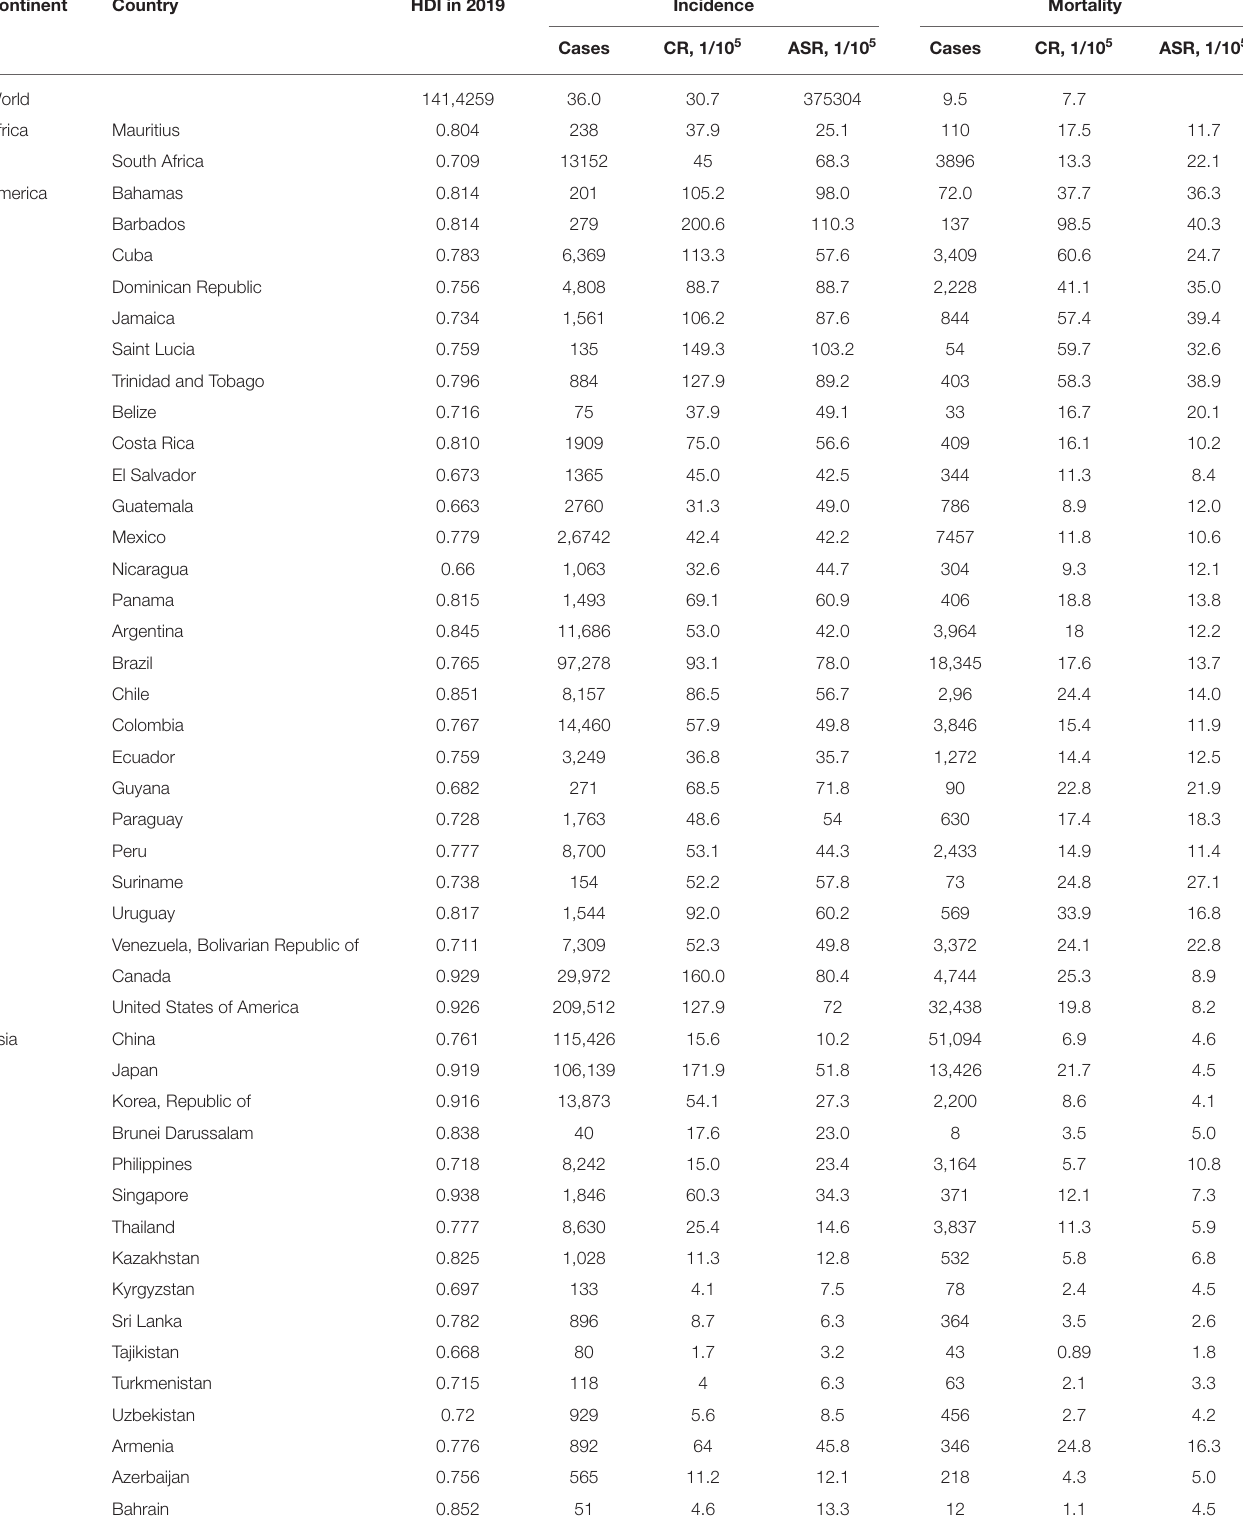
TABLE 1 | Estimated incidence and mortality of prostate cancer in the 89 countries in 2020. Continent Country HDI in 2019 Incidence Mortality Cases CR, 1/10 5 ASR, 1/10 5 Cases CR, 1/10 5 ASR, 1/10